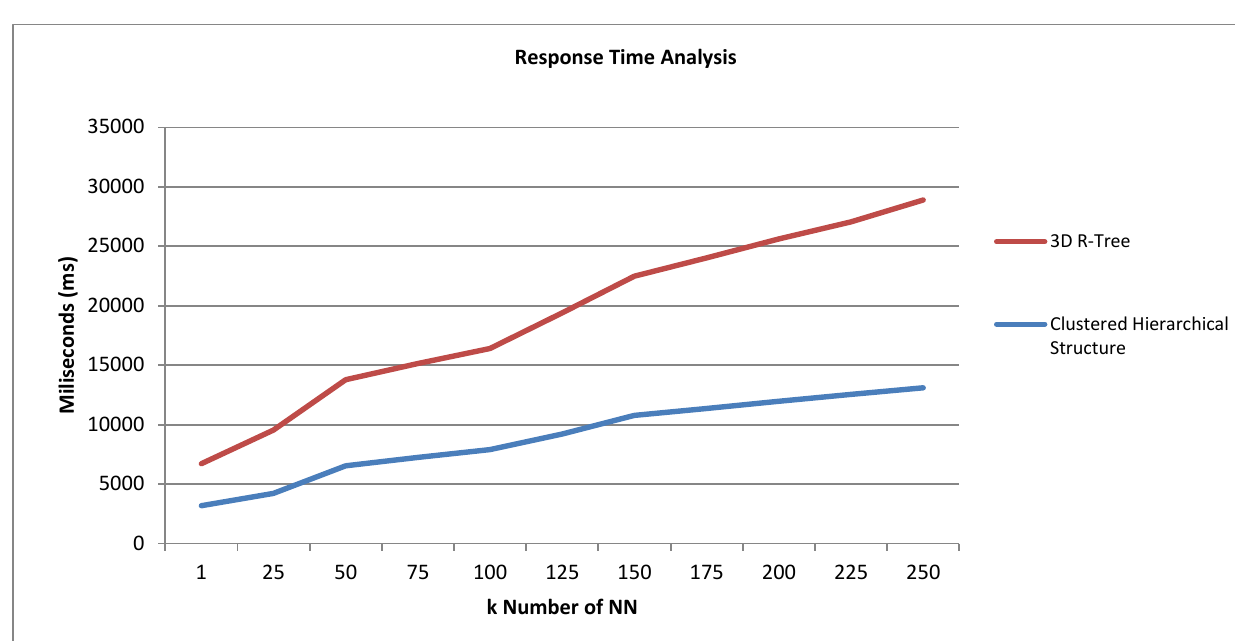
Figure 8. Response time analysis for k nearest